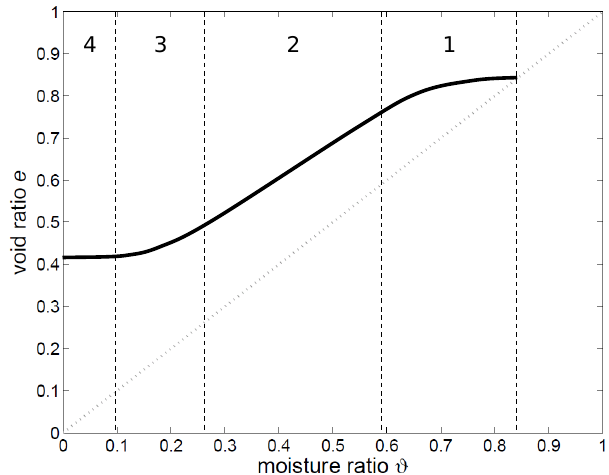
Fig. 1. Theoretical soil shrinkage curve, including 4 shrinkage phases: (1) structural shrinkage, (2) basic shrinkage, (3) residual shrinkage, (4) zero